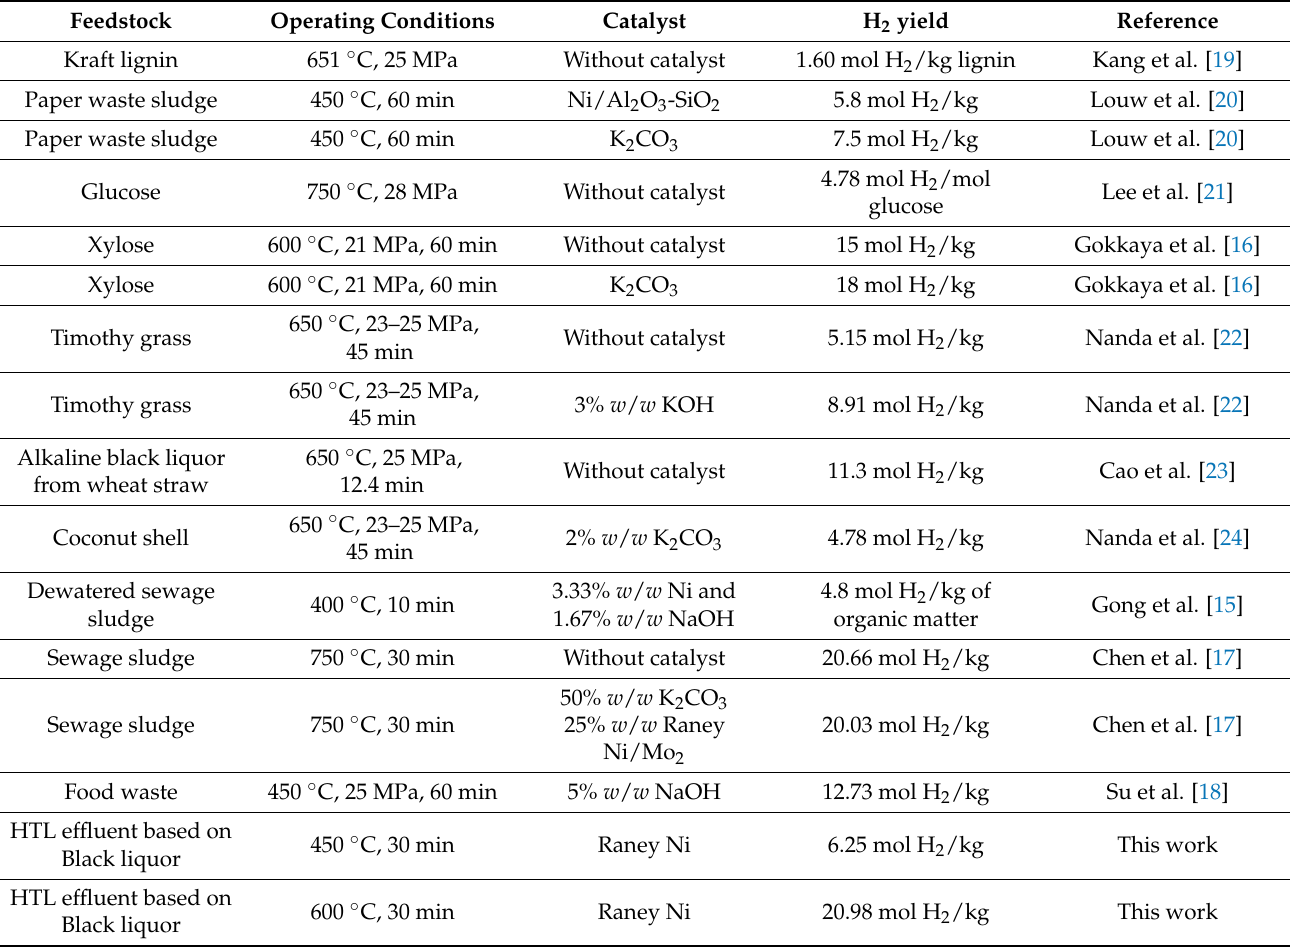
Table 2. Different biomasses and wastes tested in